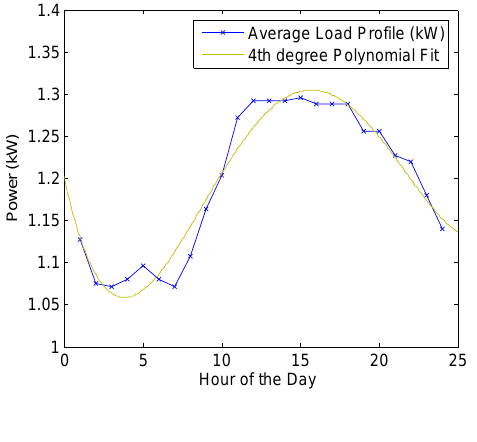
Figure 4. Telecom load profile with fourth degree polynomial